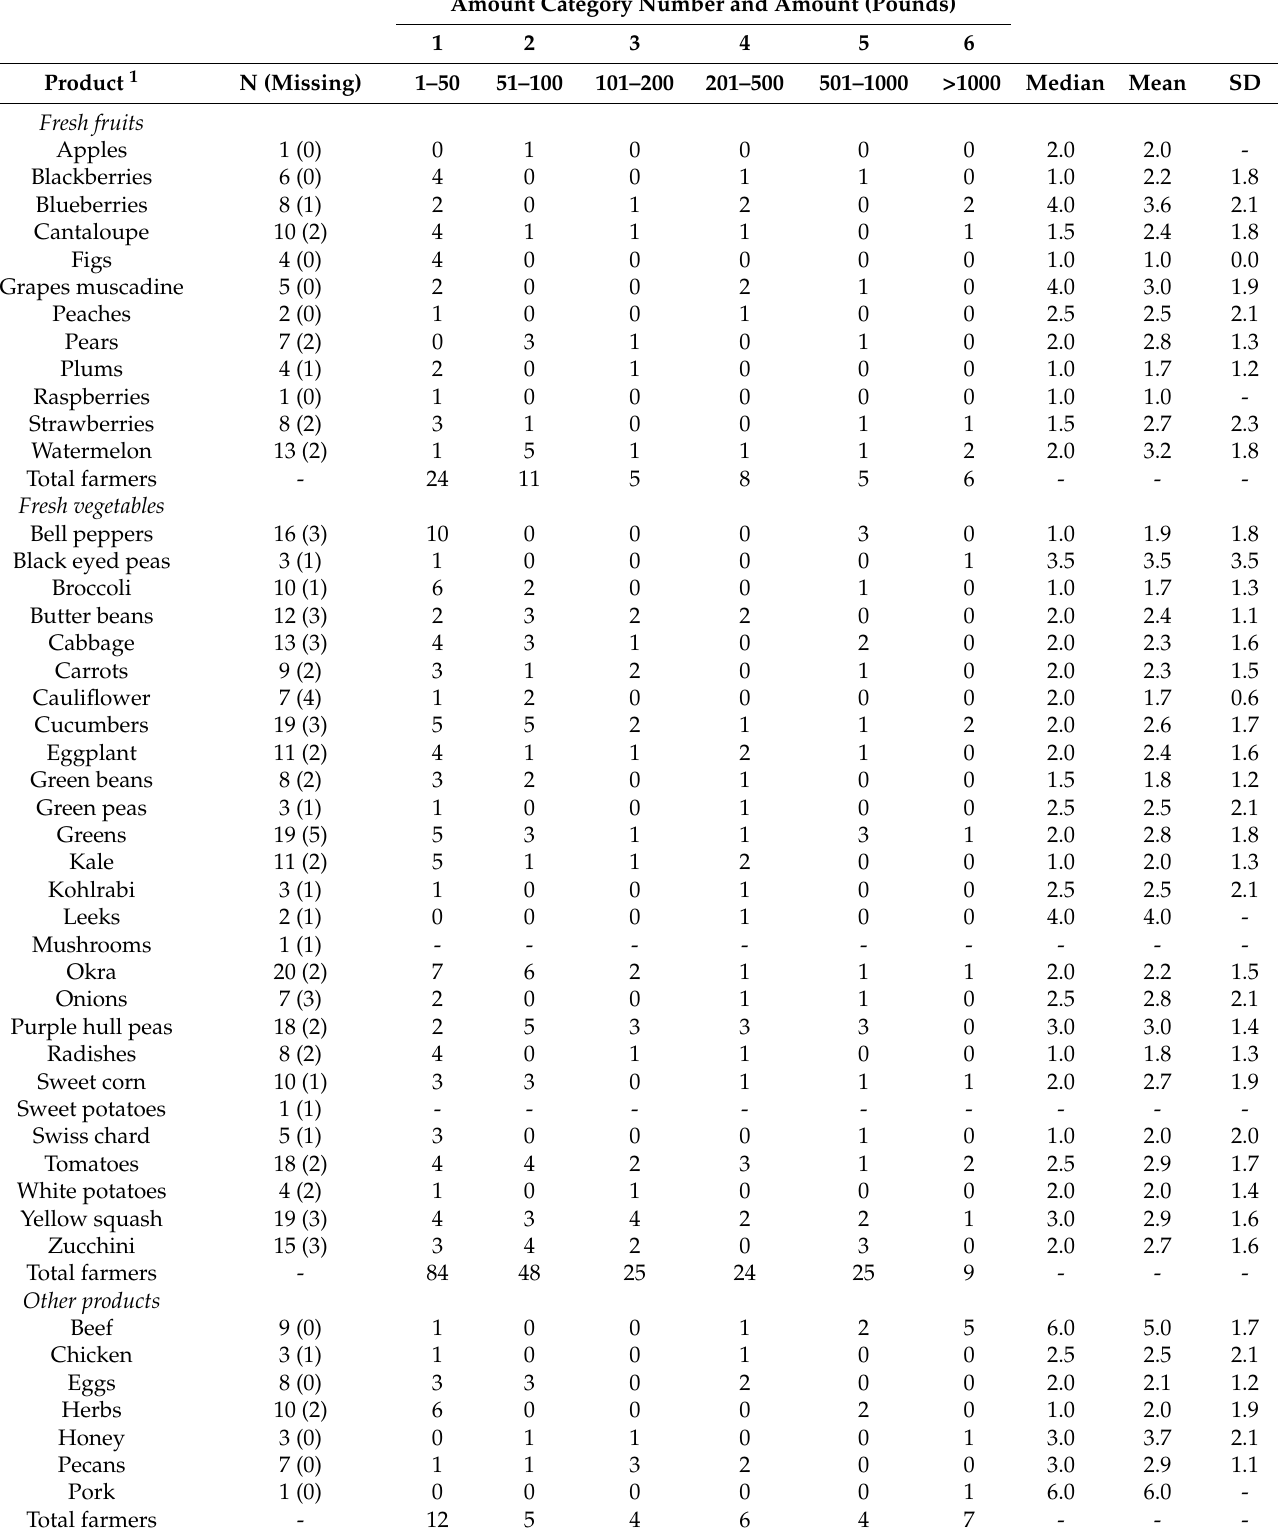
Table 1. Small farm product yearly amounts by frequencies of farmers ( n =